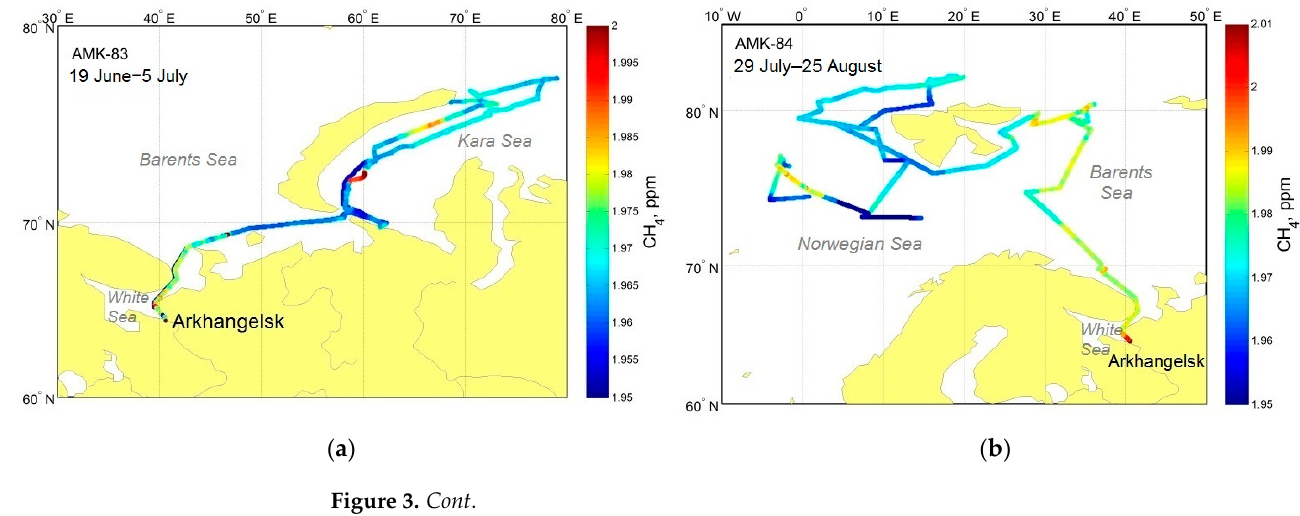
( c ) Figure 3. Variation in methane mole fraction in surface layer during the cruises of R/V Akademik Mstislav Keldys in summer and autumn of 2021 ( АМК -83 ( a ), АМК -84 ( b ), and АМК -85 ( c )). Data filtering. Data from a meteorological station (AIRMAR 150WX, (AIRMAR Technology Corp., Milford, NH, USA) was used to exclude the influence of the ship ’ s stack emissions. We used the relative wind direction, where a tailwind could bring smoke from the ship ’ s chimney back onto the system and thus contaminate the meas- urements. We also used CO 2 data; potentially contaminated data corresponded to an in- crease in concentration of 10 ppm or more from the mean for each analyzed region. In total, about 7% of the data were flagged as potentially contaminated by the ship and not considered in the following analysis. 3. Results Separate regions were allocated for three expeditions: White Sea, Barents Sea, Kara Sea, Norwegian Sea, and for the port of Arkhangelsk. The statistical characteristics were calculated for these areas and for the concentration of CH 4 and isotopic signature δ 13 C (Table 1). The obtained dataset allows us to identify some regularities in the spatial and temporal variability of the methane concentration in the lower atmosphere; first of all, there is a good correspondence between the СН 4 concentration values and the direction of air mass removal in the periods of analyzed cruises.